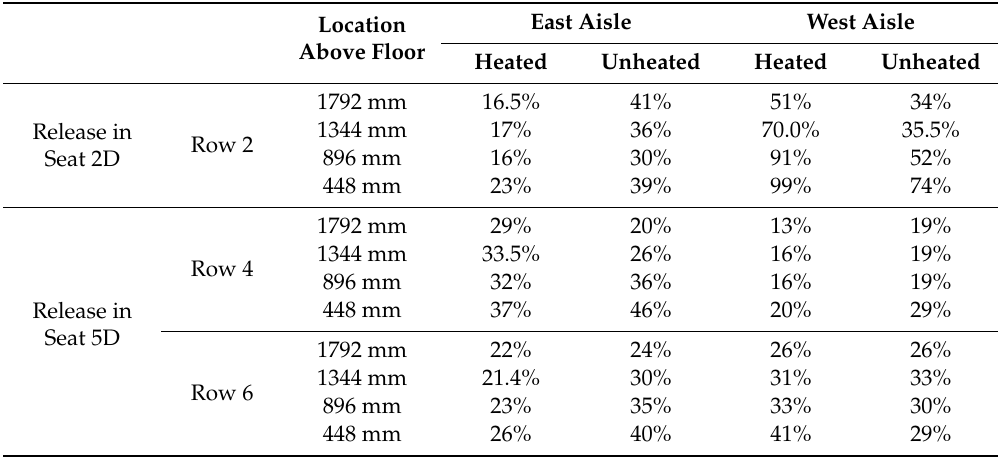
Table 1. Vertical normalized tracer gas comparison with heated and unheated cases.